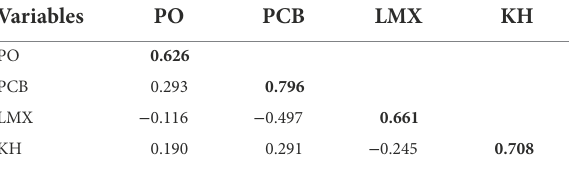
TABLE 4 Square root of AVE and correlation